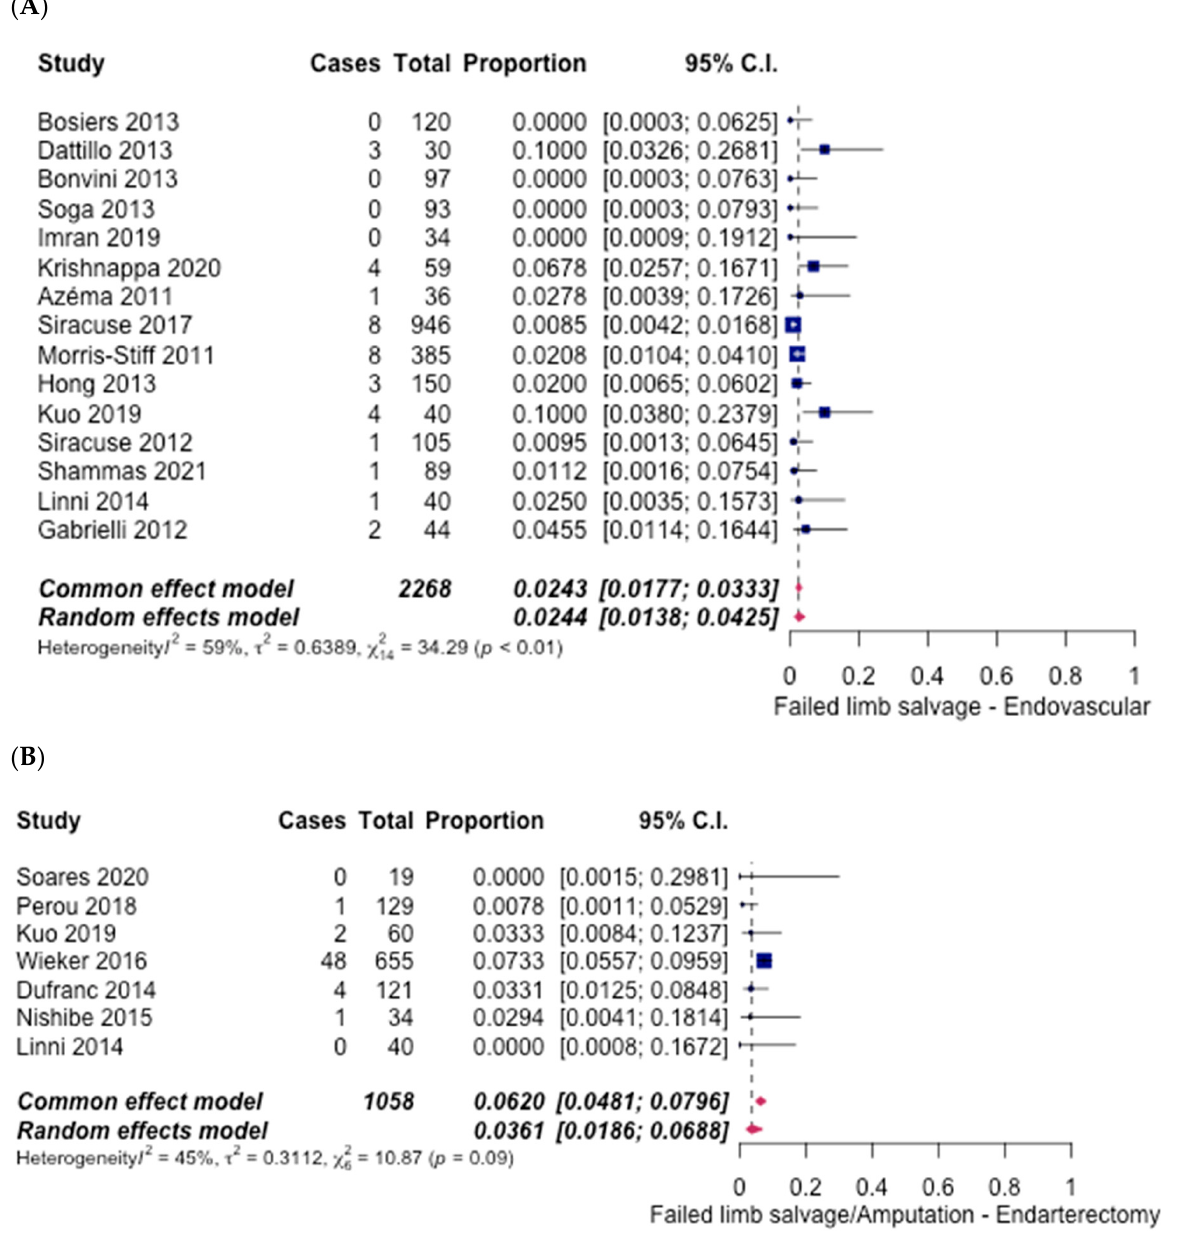
Figure 6. Forest plot for failed limb salvage/amputation. ( A ) Endovascular intervention [6–8,10–